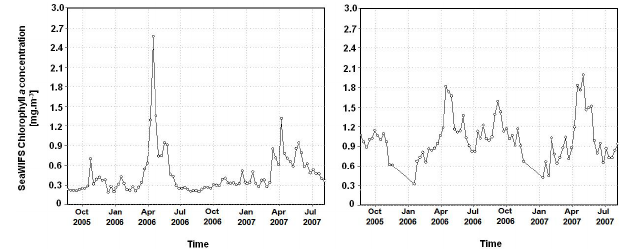
Fig. 3. SeaWIFS chlorophyll- a distribution (8-days average) for the Bay of Biscay area (left) and the English Channel area (right) be- tween September 2005 and July 2007. Graphs generated by NASA’s Giovanni